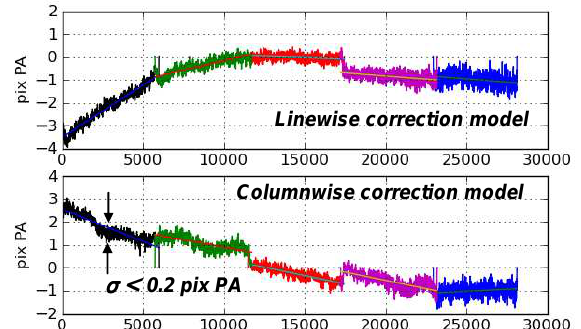
Figure 7 : PA focal plane cartography in-orbit corrections